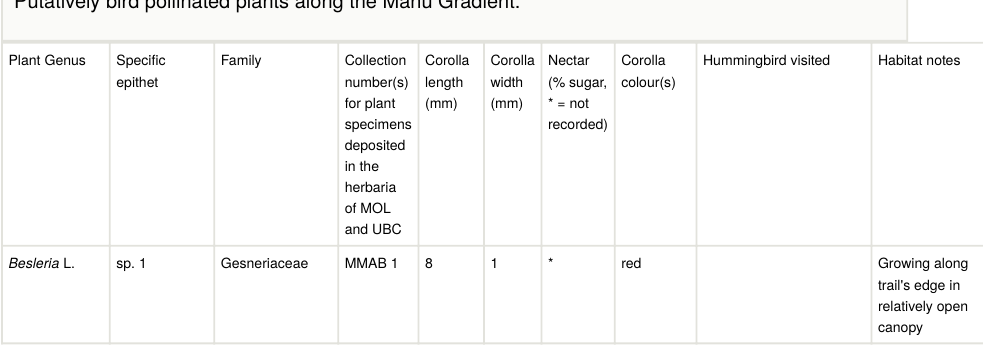
Putatively bird pollinated plants along the Manú